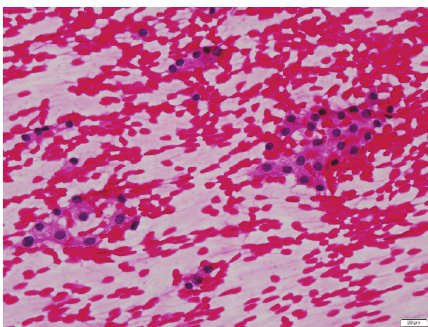
Figure 3: Fine needle aspiration (FNA) cytology: benign, consistent with hyperplastic/adenomatoid nodule (H&E, 400x).